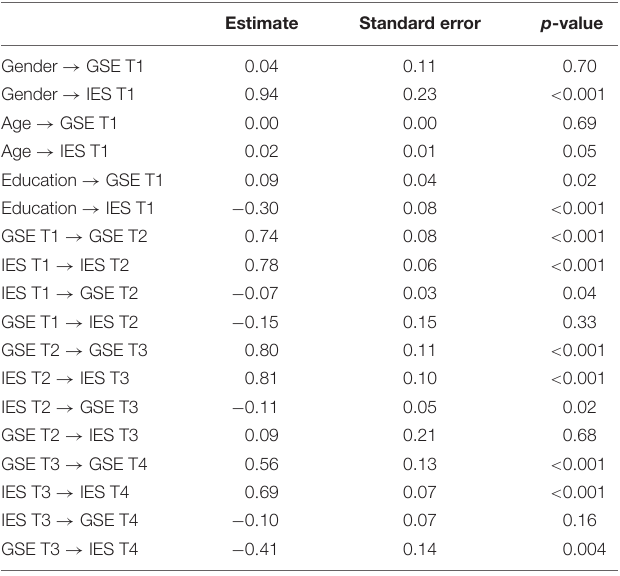
TABLE 4 | Regression weights for cross-lagged SEM model of posttraumatic stress symptoms and self-efficacy over time. Estimate Standard error p -value